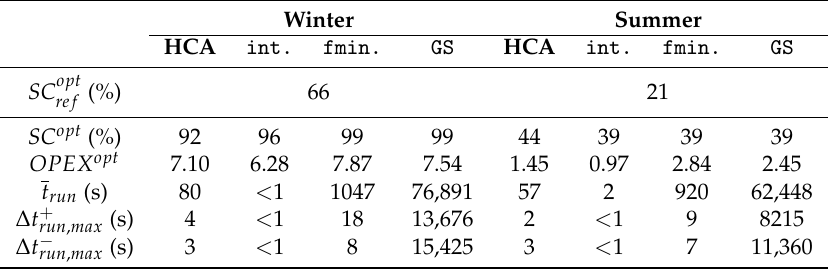
Table 3. OPEX ( OPEX opt ), PV self-consumption ( SC opt ) and mean run time ( t run ) results of the heuristic control algorithm (HCA), intlinprog , fmincon and GlobalSearch solvers for a single 48-h optimisation for winter and summer. The self-consumption rate compared to a reference case ( SC opt is shown, considering that the entire HP load is met only by importing grid electricity. Upper/lower uncertainty limits ( ∆ t + run , max and ∆ t − run , max , respectively) denote, with respect to its mean value, the maximum run time variability observed after repeating each optimisation twenty times, except for GlobalSearch, which was run only five